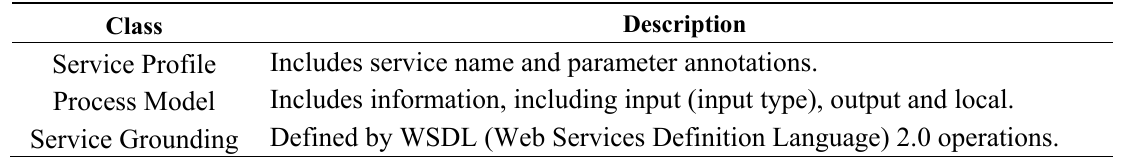
Table 2. High level OWL-S classes.